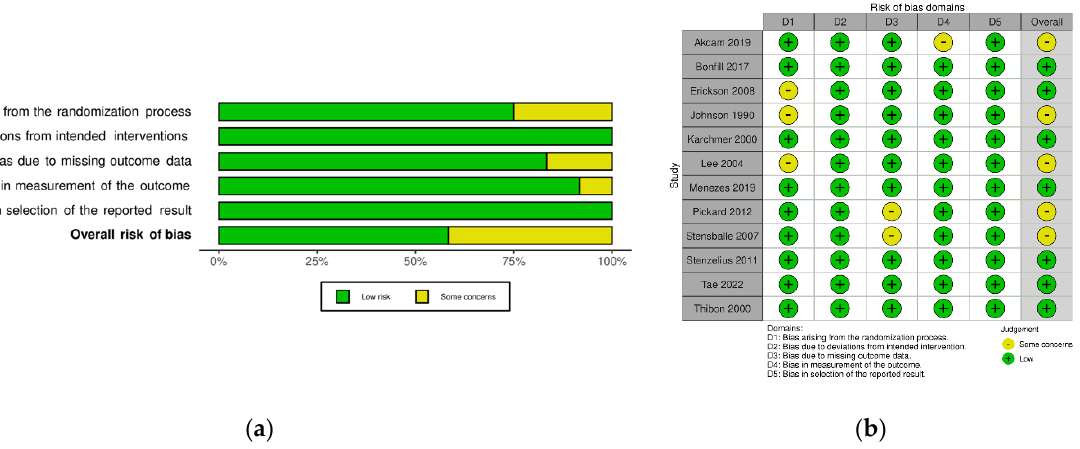
Figure 2. Risk of bias of the included study (Rob2): ( a ) review authors’ judgments about each risk of bias item presented as percentages across all included studies; ( b ) review authors’ judgments about each risk of bias item for each included study.